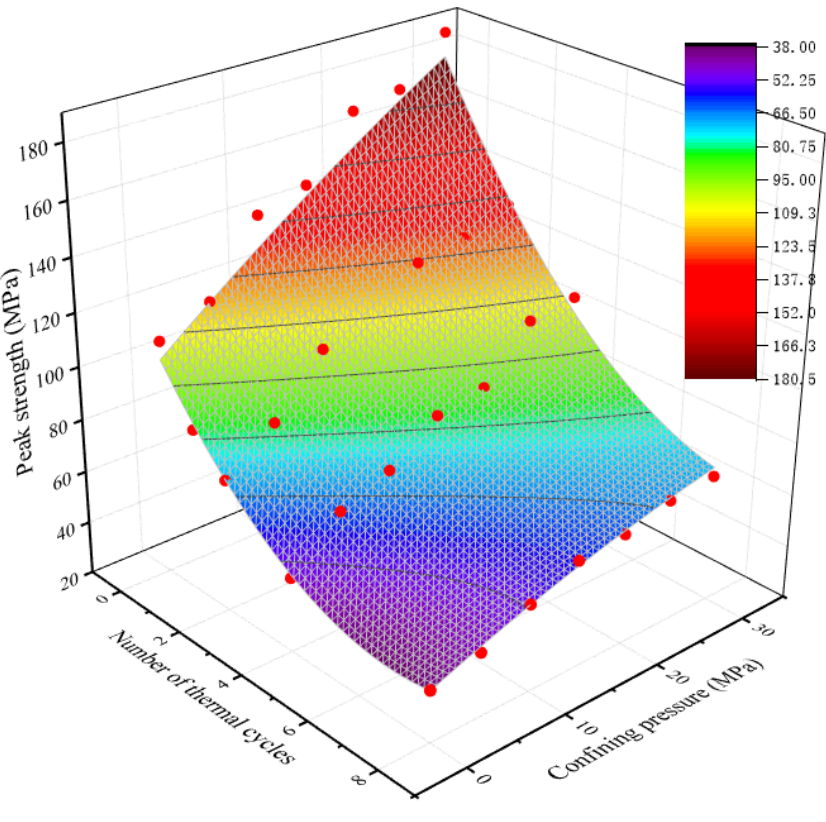
Figure 8. Triaxial compressive strength evolution of marble under thermal cycles.